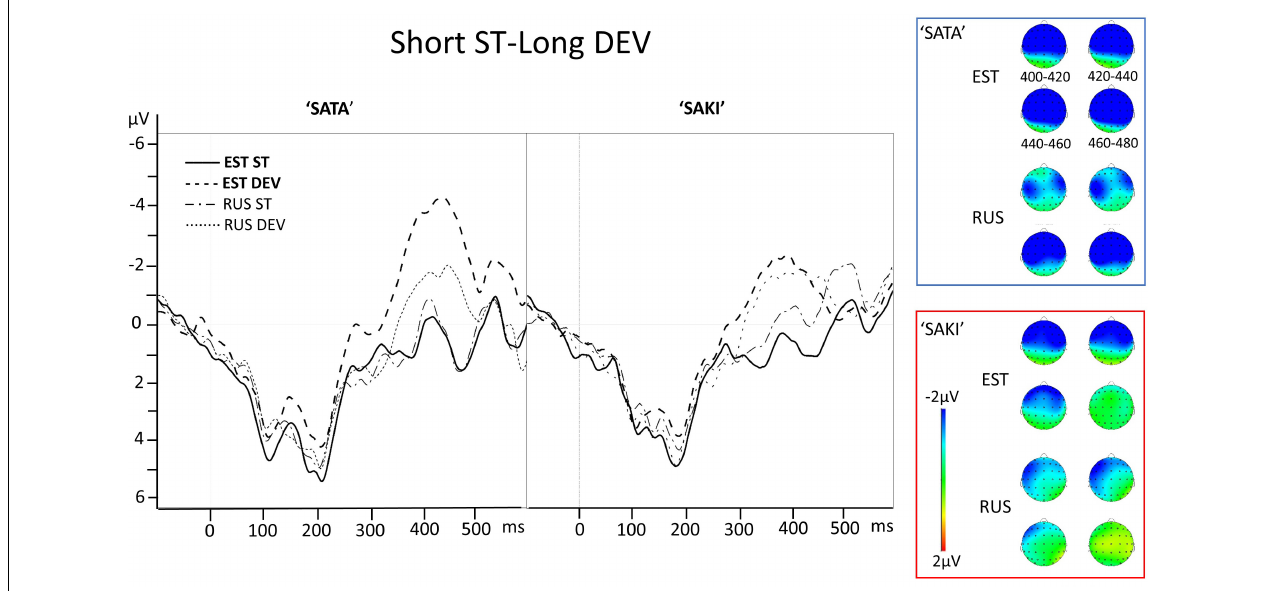
FIGURE 2 | Electrode AF3 averaged ERP activity for standard (ST) and deviant (DEV) stimuli in ‘Short ST-Long DEV’ comparisons for ‘SATA’ and ‘SAKI’ word set in Estonian (EST) and Russian (RUS) Language groups. Right panel represents distribution of averaged mismatch response (DEV-ST) in 400–480 ms. Please observe, that first 83–100 ms are exactly the same for ST and DEV under comparison (consonant, see stimuli in Figure 1